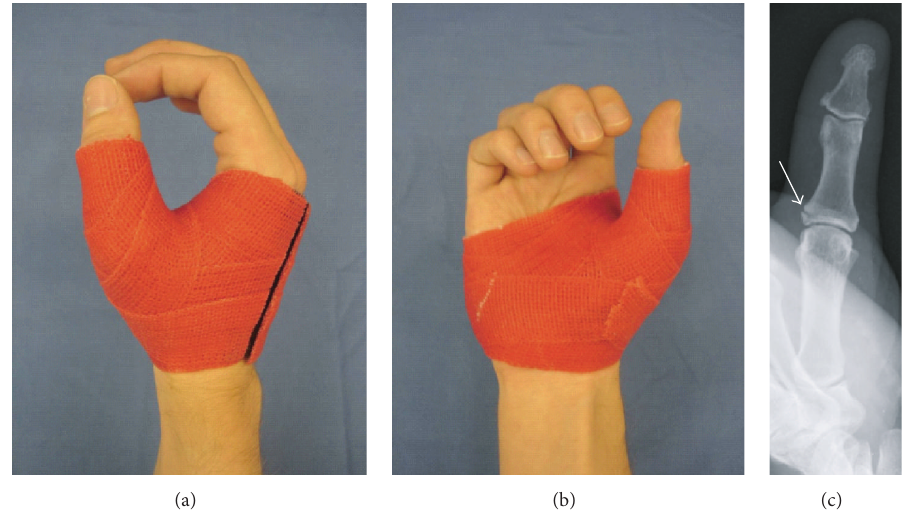
Figure 2: Thumb orthoses: (a) dorsoradial and (b) palmar view and (c) case sample: X-ray at 6 weeks after wearing orthoses following bony ulnar collateral ligament traumatic lesion (DASH analysis of case series: 𝑛 = 11 ; score-mean = 29.9 ± 1.73 SD; DASH follow-up interval (weeks): 9.5 ± 2.01